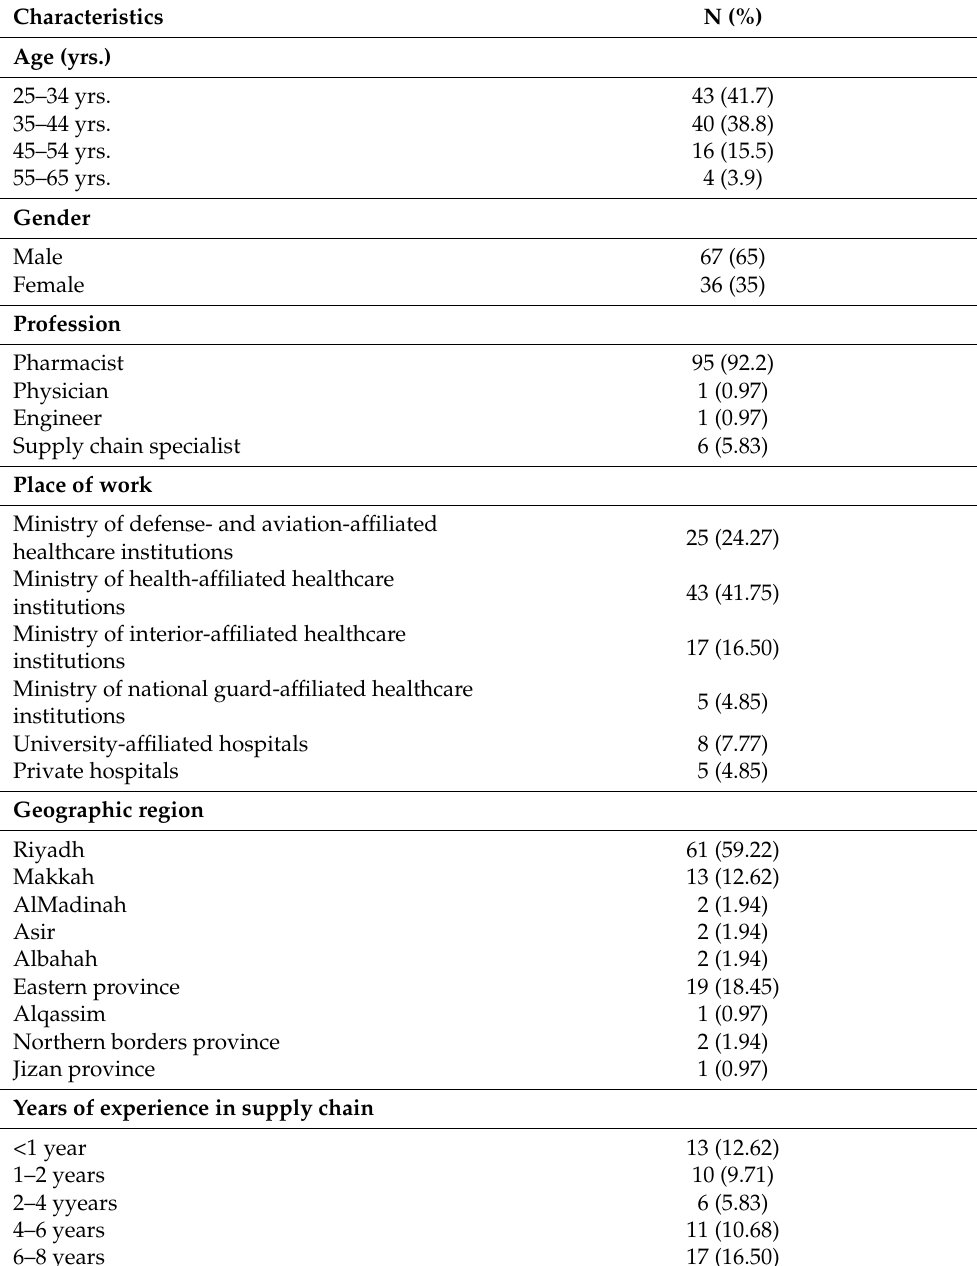
Table 1. Participants’ baseline characteristics (N = 103).